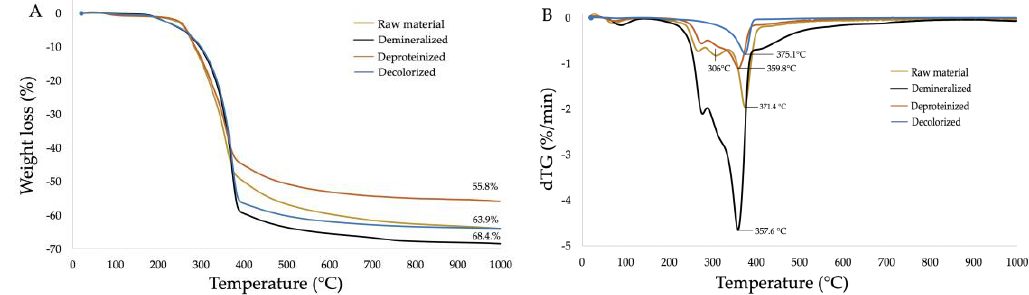
Figure 4. ( A ) TGA and ( B ) DTG of raw material, demineralized, deproteinized, and decolorized samples.